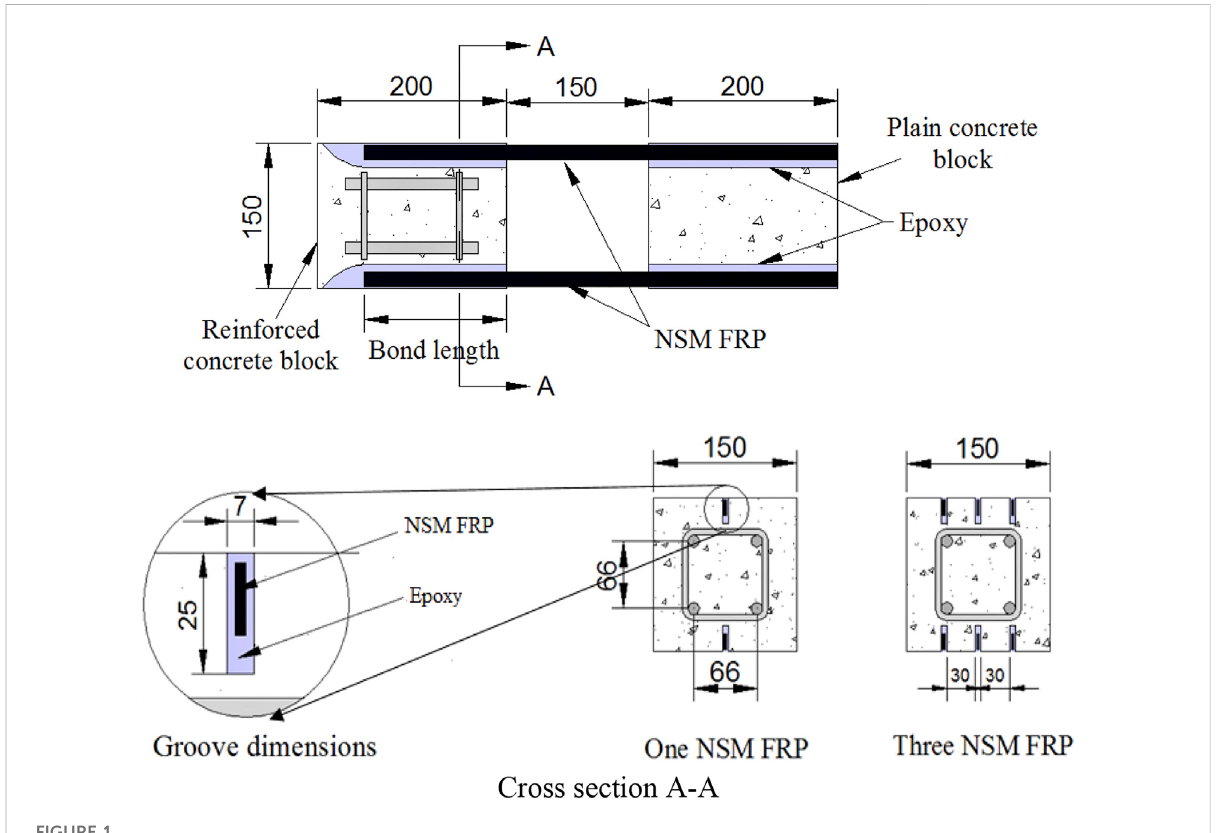
FIGURE 1 Schematics of specimens mounted with NSM (dimensions are in mm).